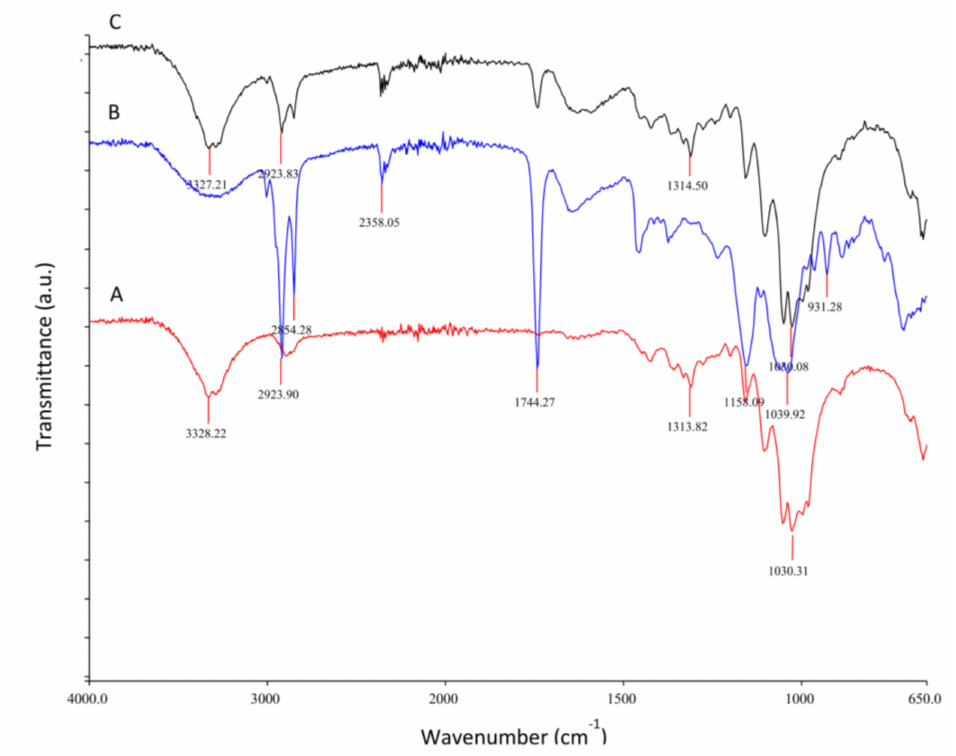
Figure 3. ATR FTIR spectrum of non-treated cotton tampon ( A red), spectrum of CBD liposome functionalized cotton tampon on outer side ( B blue), and spectrum of CBD liposome functionalized cotton tampon on inner side ( C